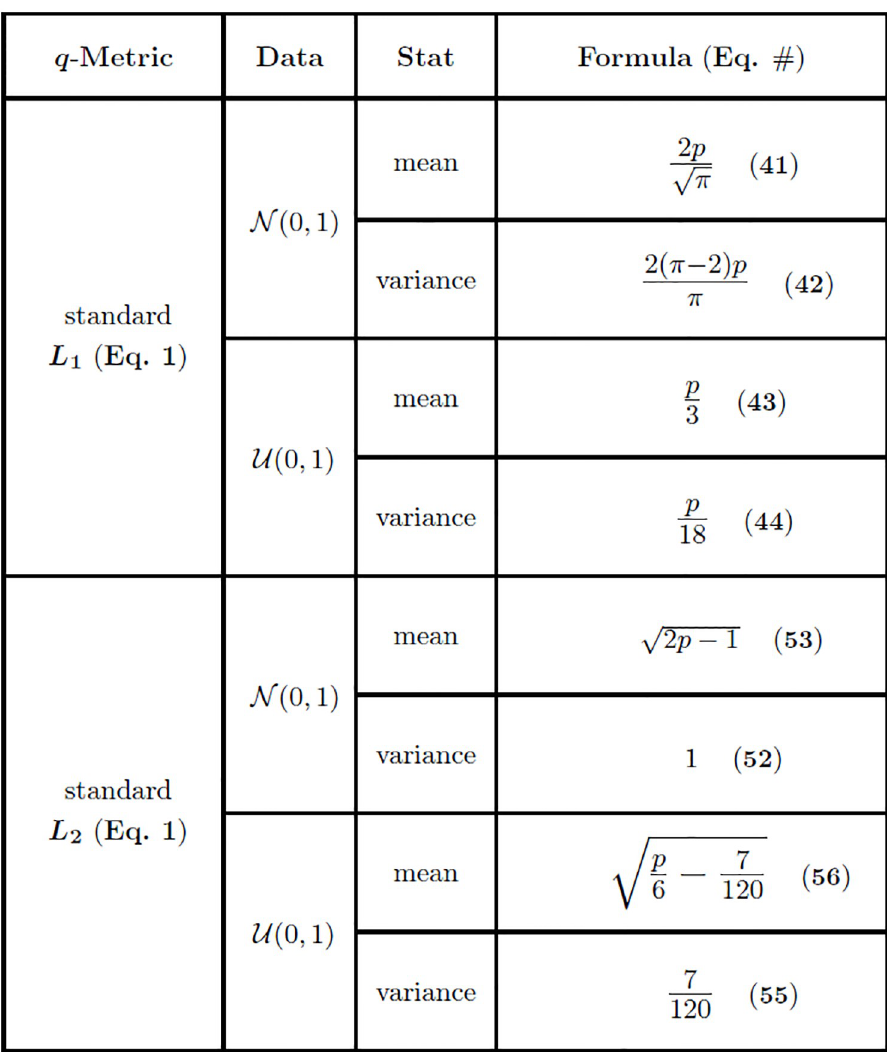
Fig 3. Asymptotic estimates of means and variances for the standard L 1 and L 2 ( q = 1 and q = 2 in Fig 2) distance distributions. Estimates for both standard normal ( N ð 0 ; 1 Þ ) and standard uniform ( U ð 0 ; 1 Þ ) data are given.